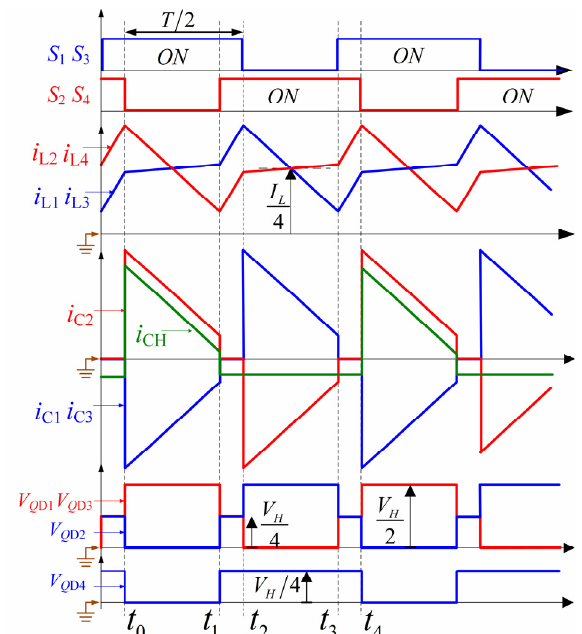
Figure 8. Operating waveforms for the CCM Boost stage.